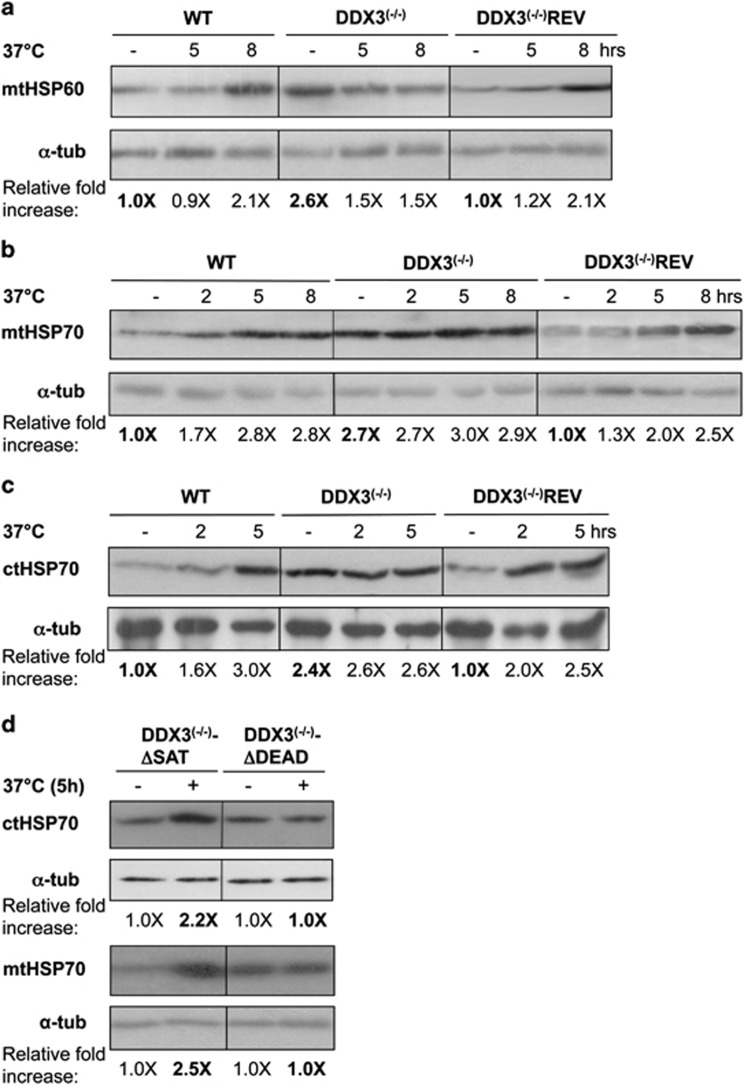
Inactivation of DDX3 activates key components of the mitochondrial unfolded protein response. Western blot analysis of total lysates from L. infantum WT, DDX3(−/−) and DDX3(−/−)REV strains exposed to heat stress (37 °C) at different time points using an antibody recognizing the mitochondrial (mt) HSP60 (a) or mtHSP70 (b) or the cytoplasmic (ct) HSP70 (c) proteins (the same number of cells were loaded). Conditions of heat stress were compared with parasites grown at 25 °C. The same membrane was blotted with an anti-α-tubulin antibody (loading control). (d) Western blot analysis of total lysates from DDX3(−/−) parasites complemented either with the DDX3ΔDEAD or the DDX3ΔSAT mutant proteins and subjected or not to heat stress (5 h) using an anti-ctHSP70 antibody. Data shown here are representative of three independent experiments yielding similar results. Relative fold increase was calculated from three experiments and within each strain (e.g., WT, DDX3(−/−) and DDX3(−/−)REV) values correspond to the ratio of heat-stressed versus unstressed parasites normalized with the α-tubulin protein. Values in bold represent steady-state levels of mtHSPs in DDX3(−/−) and DDX3(−/−)REV relative to WT levels (a–c). In panel (d), values in bold are relative to the unstressed control